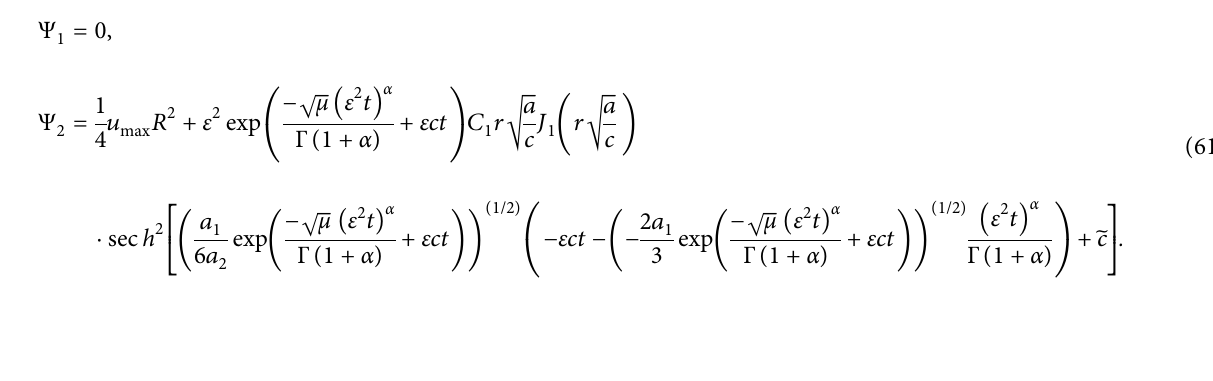
� − 1 ,a � − 20 , 􏽥 c � 0 , μ � 0 . 005 ) 2 1